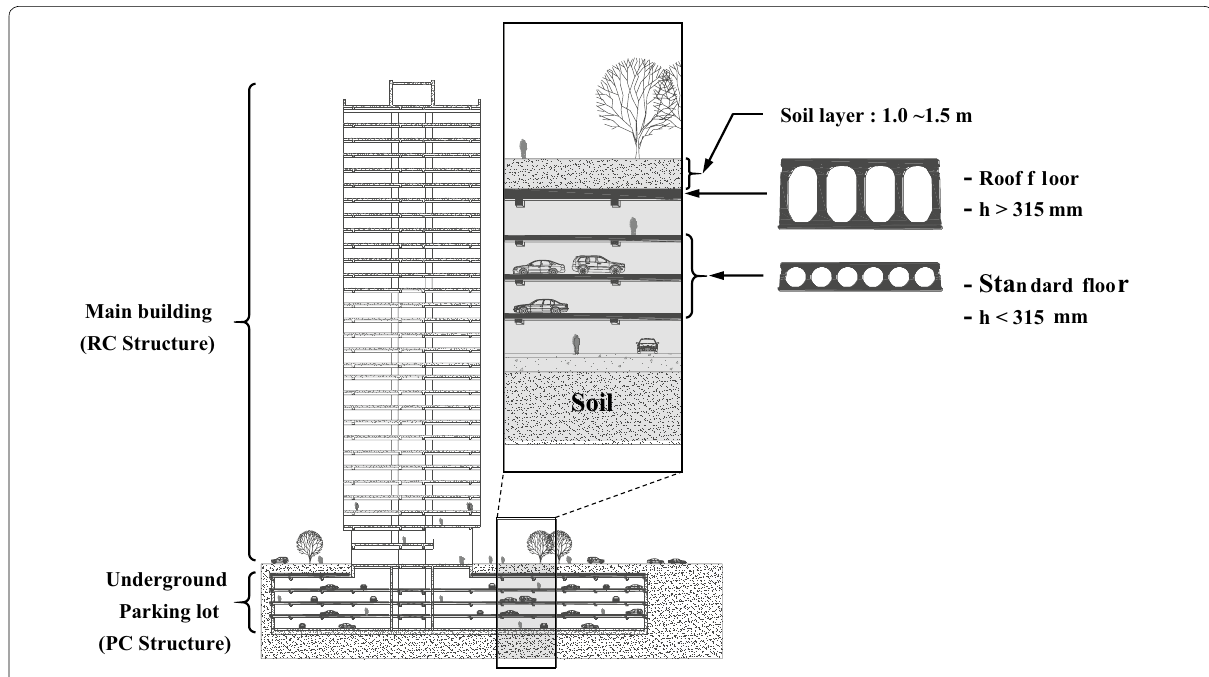
Fig. 3 Typical underground parking structure of a multiplex